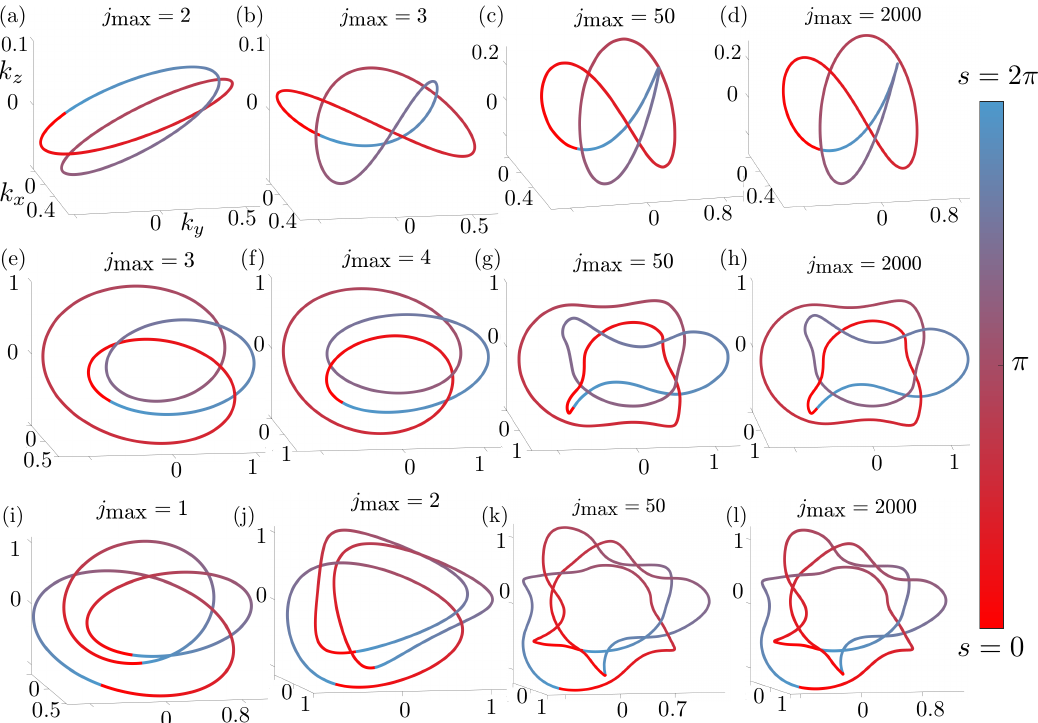
Figure 4: An illustration of the transitions occurring for the parameterised curves. For small j the topology of the parameterisation does not resemble that of the max nodal structure, but when considering additional modes it will eventually transition towards the correct topology. In (a)-(d), parameterisations of a trefoil for different = 3 – the curve in (b) is a j are shown, with a transition taking place at j max max trefoil knot, while (a) shows an unknot. In (e)-(h) the figure-eight knot is approxi- mated. Interestingly enough, the curve in (e) actually resembles a trefoil knot, while (f)-(h) inherit the topology of a figure-eight knot. The lower bar (i)-(l) represents pa- rameterisations of the Borromean rings, where the transition to the correct topology = 2. Noteworthy is that the structure in (i) consist of three occurs already for j max individually linked circles, which are unlinked for larger j . The topological tran- max sitions occurring for these structures are observed by computing the corresponding Alexander polynomial, which are presented in Tab.